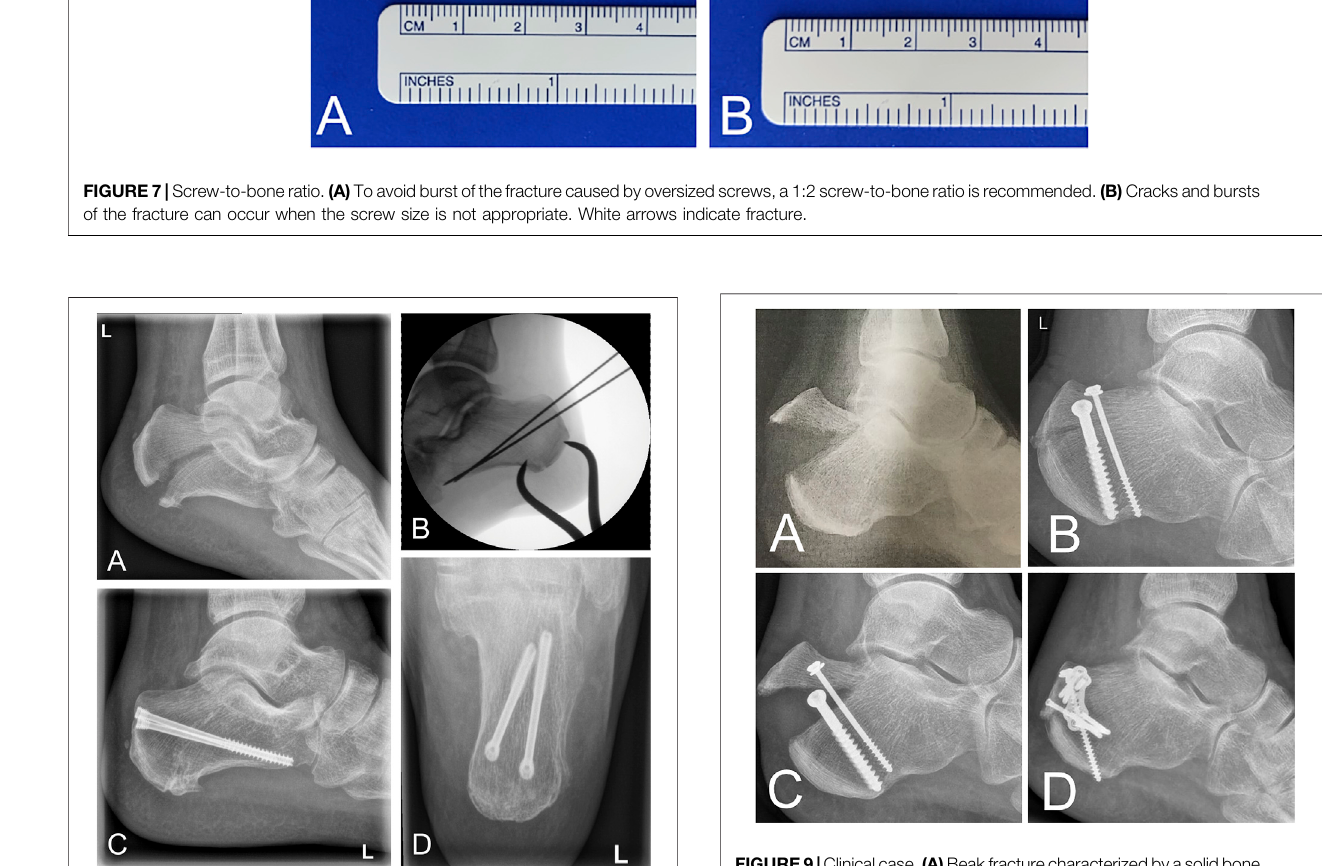
FIGURE9| Clinicalcase. (A) Beakfracturecharacterizedbyasolidbone partina61-year-oldfemalepatient. (B) X-rayafterurgentreductionandscrew fi xation. (C) Early fracture dislocation after mobilization of the patient. (D) Revision performed using a combination of screw and plate